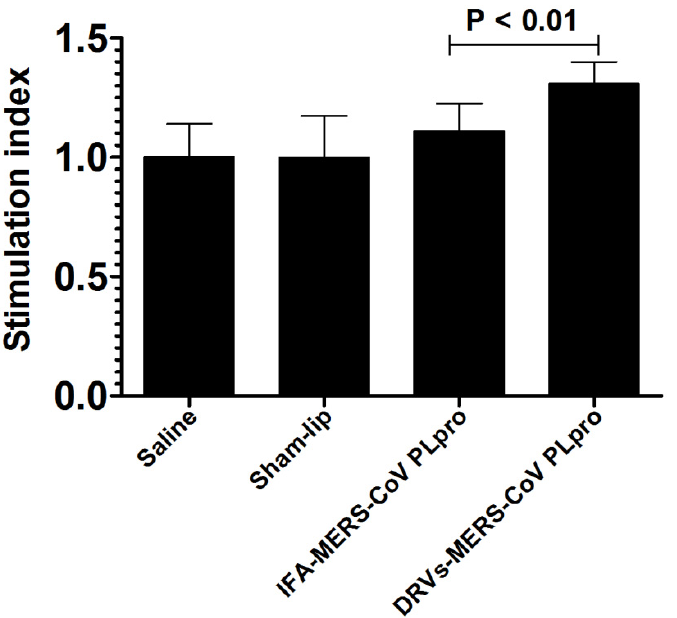
Figure 4. The splenocytes from mice immunized with DRVs-MERS-CoV PL pro showed greater antigen-specific proliferation.The data are represented as the mean ± 95% CI of the values from three mice.